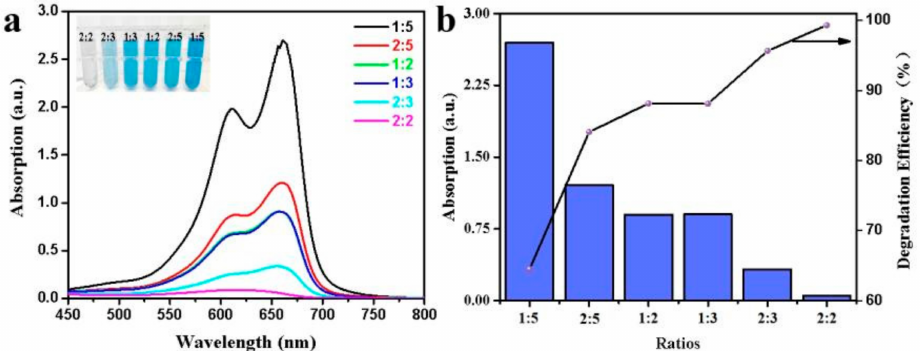
Figure 2. UV–vis absorption degradation curves of MB catalyzed by MoS 2 /Au at different addition ratios (MoS 2 (mg): HAuCl 4 (wt. % mL)) ( a ); Histogram of absorption intensity and corresponding catalytic efficiency curve ( b